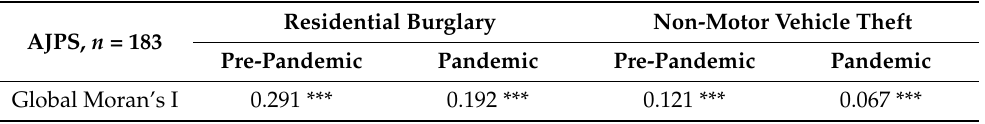
Figure 3. Spatial distribution of residential burglary and non-motor vehicle theft measured by AJPSs during the pre- (2019) and pandemic (2020) periods. Table 4. Global Moran’s I statistics of residential burglary and non-motor vehicle theft during the pre- and pandemic